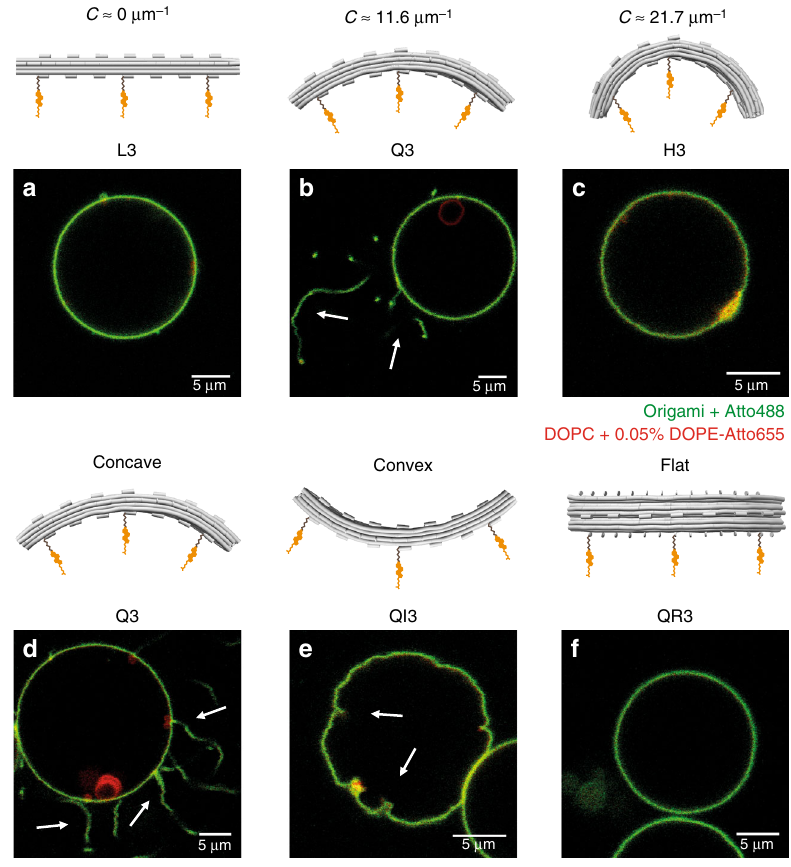
Fig. 3 Triggering of membrane deformations depends on the degree of curvature of the BAR-mimicking DNA nanoscaffolds. DNA origami structures (labeled with Atto488; green) of varying curvature (L3, Q3 and H3; here at 5 nM bulk concentration) were incubated with DOPC GUVs (labeled with DOPE-Atto655; red) for at least 1 h. After membrane binding was achieved, the surface tension of the GUVs was lowered by applying a hyperosmotic stress (10% increase in buffer osmolarity) and consequent changes in vesicle shape were monitored. No signi fi cant changes in vesicle shape were observed with membrane-bound origami L3 ( a ) and H3 ( c ). Vesicles covered with the moderately curved structure Q3 presented long tubular outward structures upon hyperosmotic stress ( b ; marked by arrows). Similarly, membrane interaction of origami Q variants displaying three cholesteryl anchors on different curved facets was further investigated. Strong binding to GUVs was achieved for all nanostructures, independently of the facet where anchors are localized ( d – f ). Upon vesicle de fl ation, the concave structure (Q3) triggered outwards membrane tubules ( d ; marked by arrows); the convex structure (QI3) triggered evagination/invagination-type of deformation ( e ; marked by arrows); and the structure with null curvature (QR3) led to no signi fi cant changes in vesicle shape ( f ). Scale bars: 5 µ